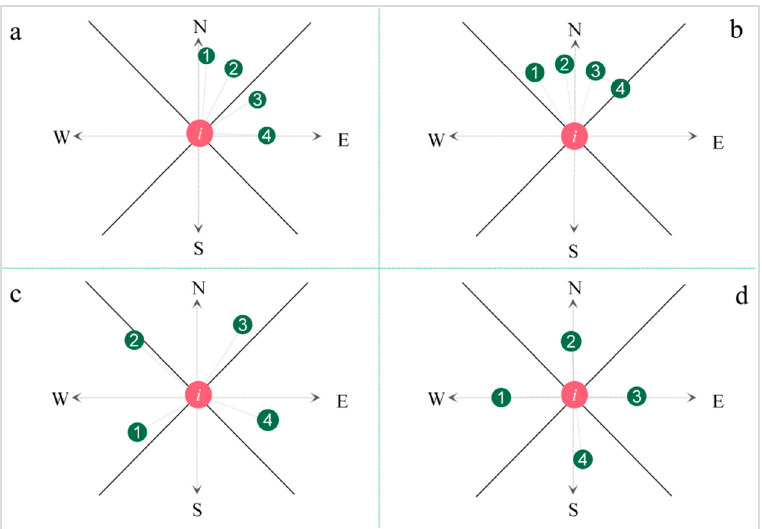
Figure 2. Schematic diagram of Adjacent trees in different orientations of the center tree. ( a , b ) Distribution when the angle between any two adjacent trees is smaller than the standard angle. ( c , d ) Distribution when the angle between any two adjacent trees is greater than the standard angle. The numbers 1–4 represent the distribution of the four adjacent trees.